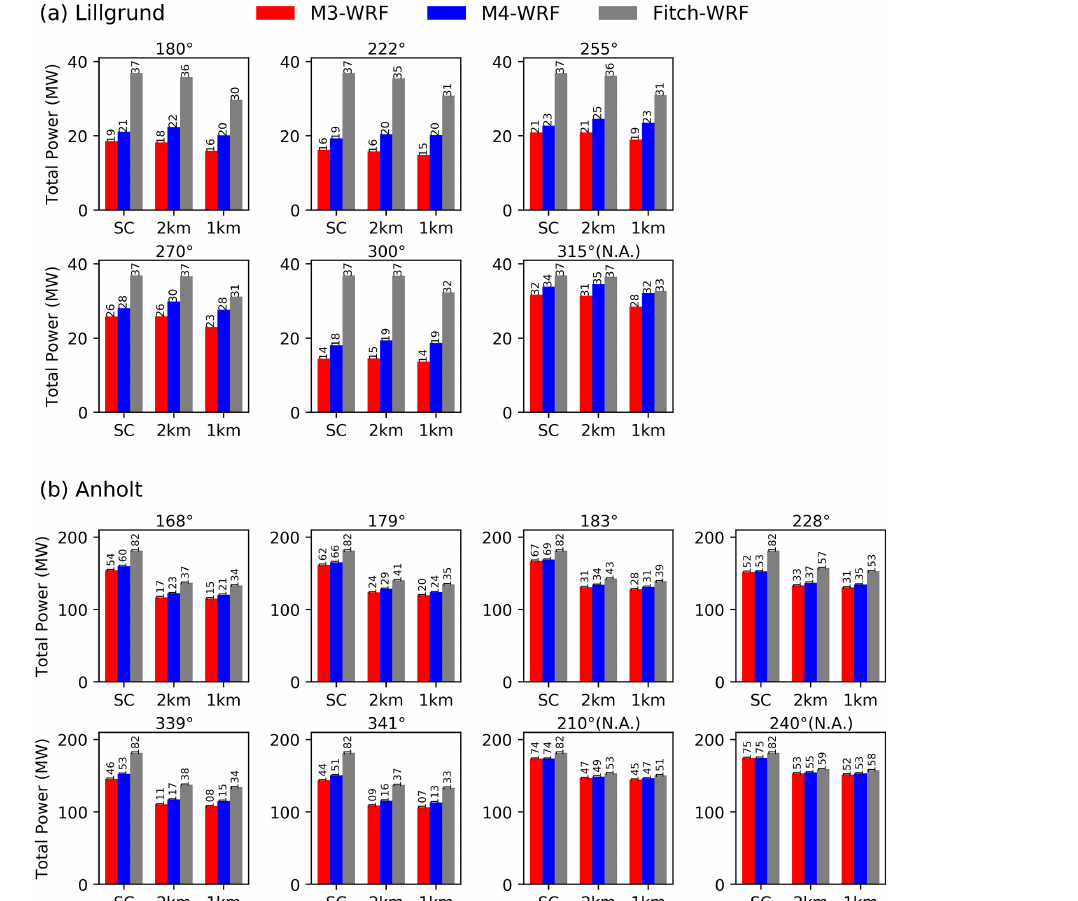
Figure 10. Total power (MW) at Lillgrund (a) and Anholt (b) from the Jensen wind farm parameterization in WRF with two wake superpo- sition methods, M3 (red) and M4 (blue), and from the Fitch parameterization (grey) from all the turbines in the farm for the selected wind directions. For each method, single-cell cases (SC) and multi-cell cases with grid resolutions of 2 and 1km are shown. The figures with “N.A.” in the title are the results for the non-alignment wind directions (315 ◦ at Lillgrund; 210 and 240 ◦ at Anholt).